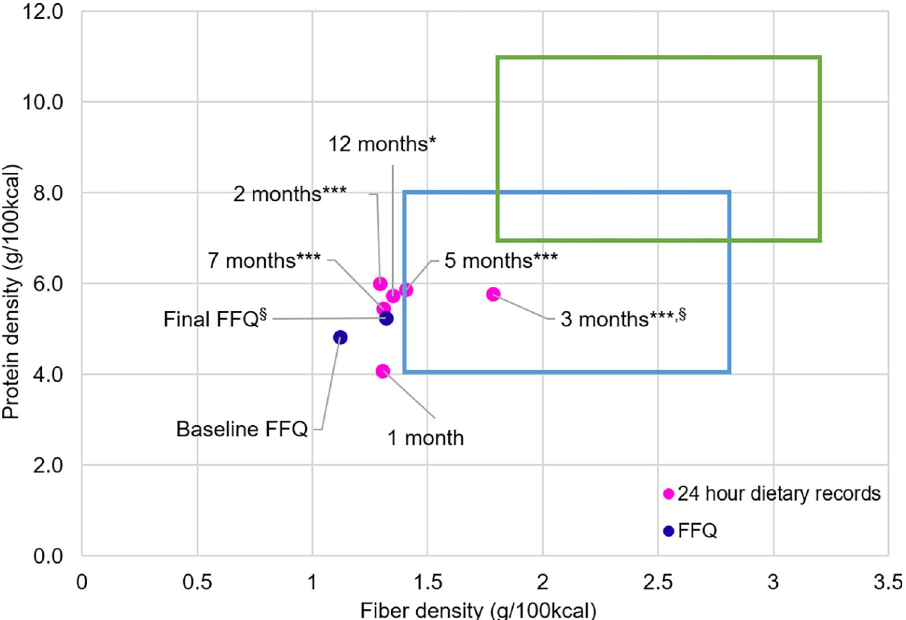
Fig 6. Changes in protein and fiber density of the whole group assessed by FFQ and 24-hour records. Data are presented as mean. FFQ were collected at the baseline (n = 12) and the end of the trial (n = 11). Twenty-four-hour records were collected at one–seven months (n = 12) and at 12 months (n = 10). Changes in protein density and fiber density were compared between baseline and 12 months in FFQ, and between the first month and two-12 months in 24-hour records. � p = 0.02, ��� p < 0.001 in protein density; §p = 0.02 in fiber density by paired t-test.